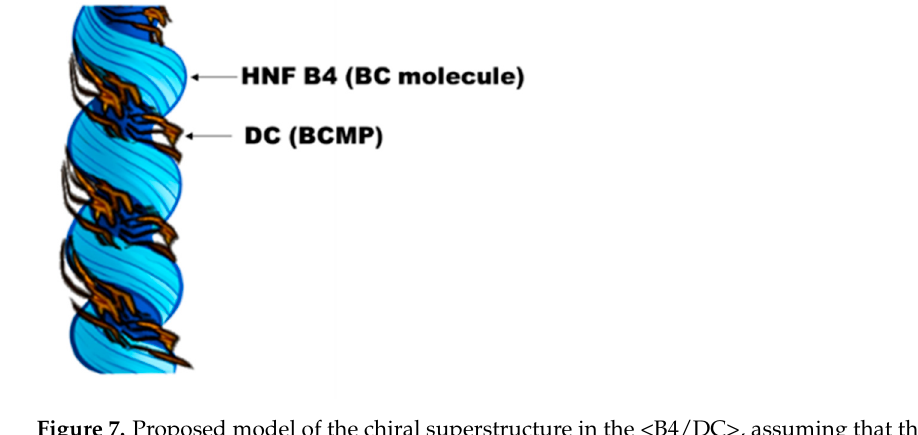
Figure 7. Proposed model of the chiral superstructure in the <B4/DC>, assuming that the polymer chains of BCMP align in parallel to the groove of the HNFs.